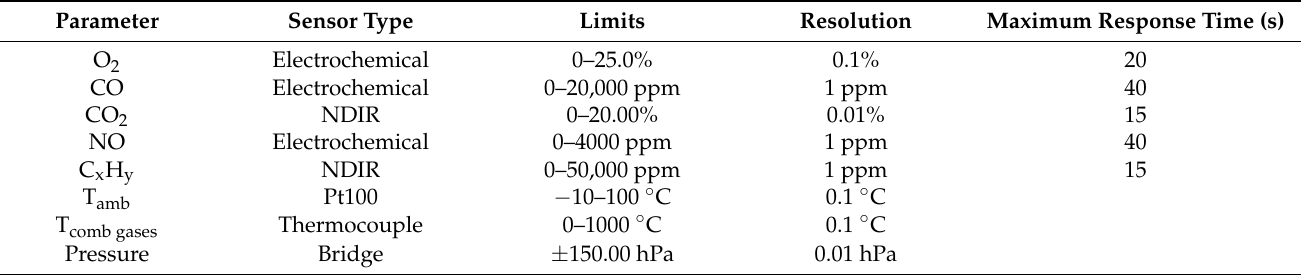
Table 1. Operational characteristics of the Greenline 8000 gas analyzer.